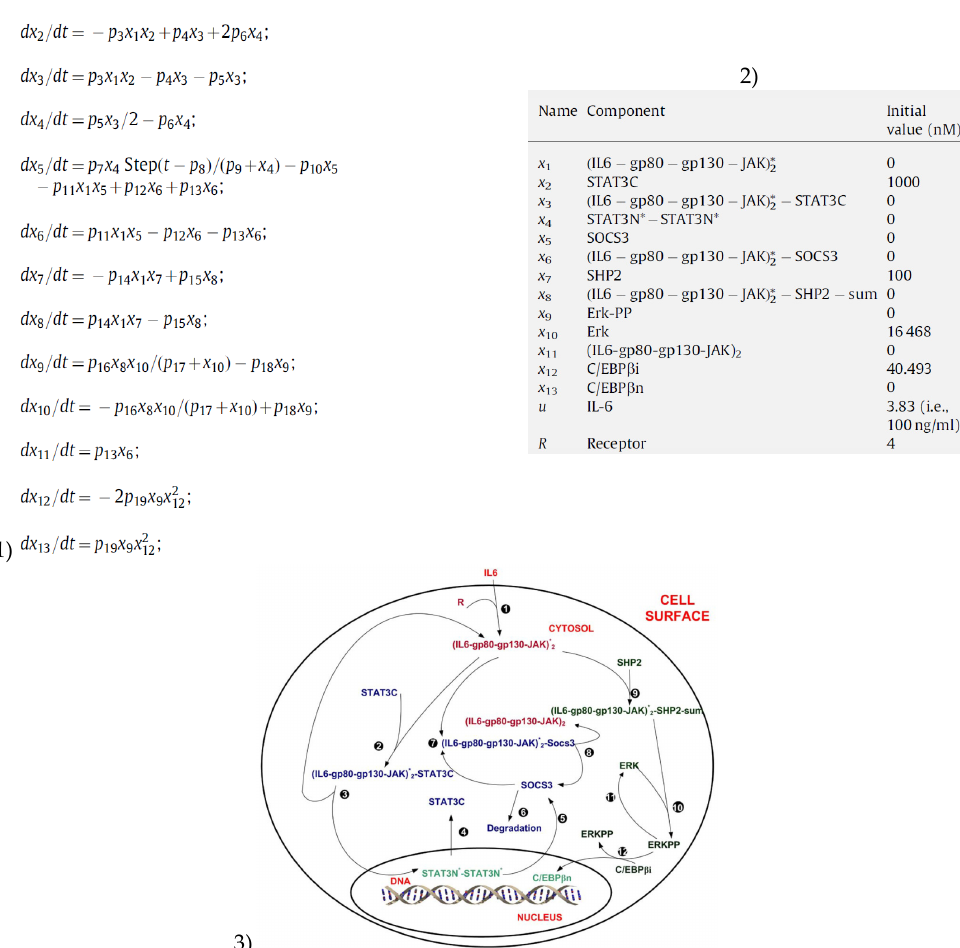
Figure A1. IL-6 model taken from [2]. ( 1 ) Model ODEs ( 2 ) initial conditions ( 3 ) schematic of the IL-6 signaling network.